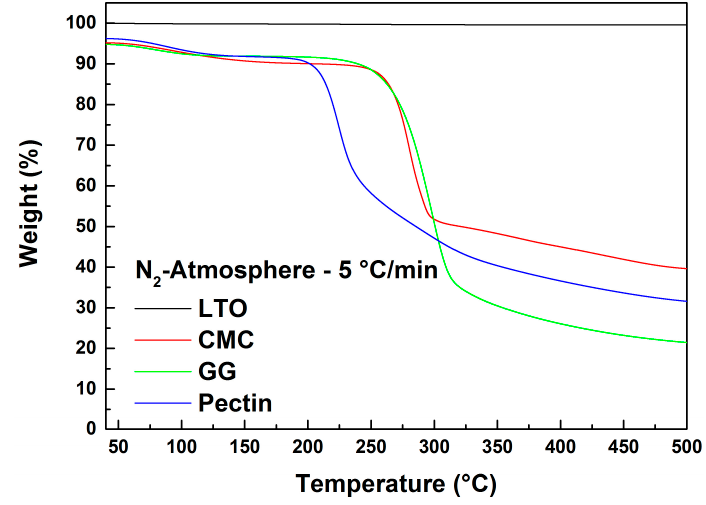
Figure 2. TGA weight loss profiles of LTO, CMC, guar gum (GG) and pectin with a heating rate of 5 °C/min in N 2 atmosphere.